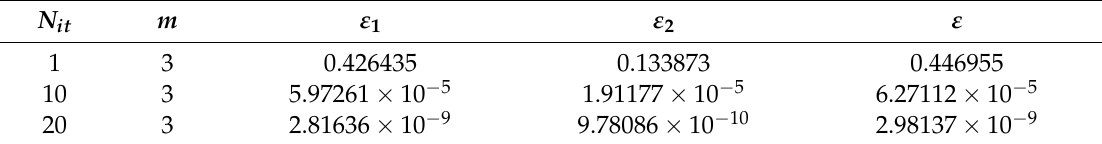
Table 4. Results for problem (31).